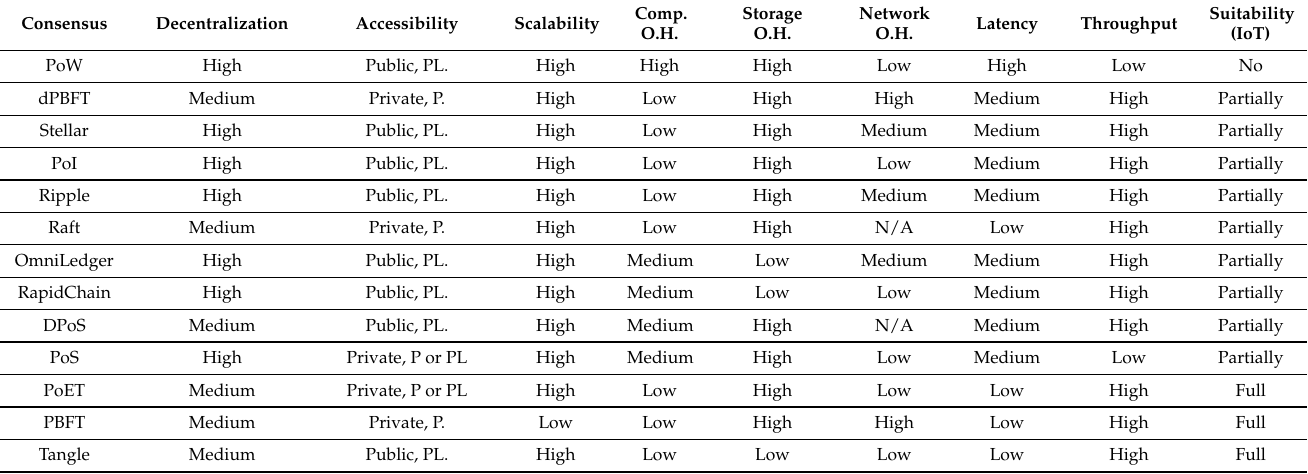
Table 1. Performance comparison for different consensus algorithms